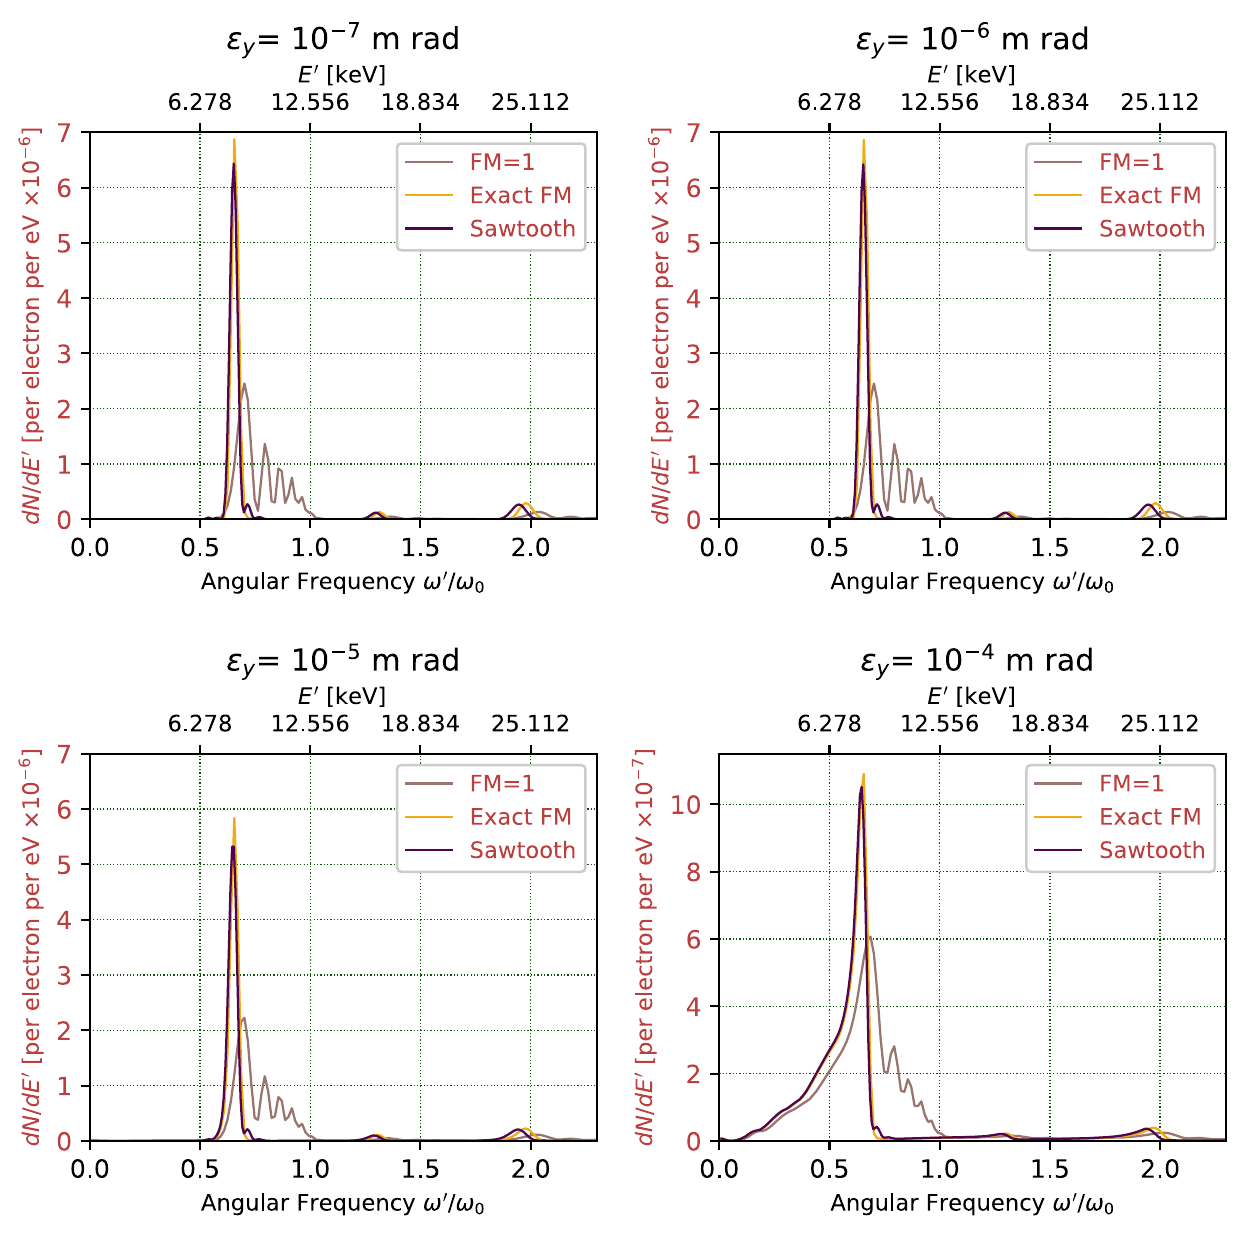
FIG. 7. Comparison of simulated spectra with three different FM functions: uncorrected simulation (FM ¼ 1 ), the optimal chirping solution [11], and a sawtooth chirping function. The simulations were conducted for a range of normalized vertical emittance ϵ y values. In the case of the most extreme emittance (bottom right panel), the spectra have been rescaled by an order of magnitude on the right vertical axis. The following parameters were used in the simulations: E e ¼ 23 MeV; Δ E e =E e ¼ 0 . 175% ; σ x ¼ 41 μ m; σ y ¼ 81 μ m; a ¼ 1 . 5 ; λ ¼ 800 nm; σ ¼ σ ¼ 13 . 59 μ m; σ ¼ 5 . 57 . Note that the scale of the y-axis is fixed for the top two plots and the lower left 0 x;l y;l plot, but the scaling on the bottom right plot has been adjusted since the peaks are a full order of magnitude smaller than the other